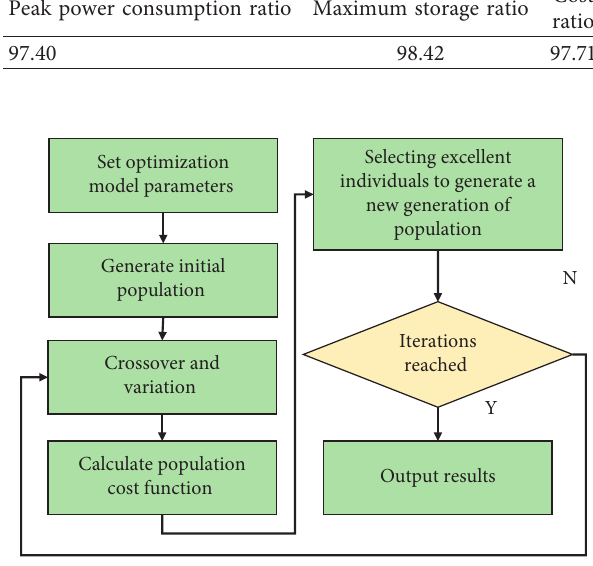
Figure 4: Optimization process.